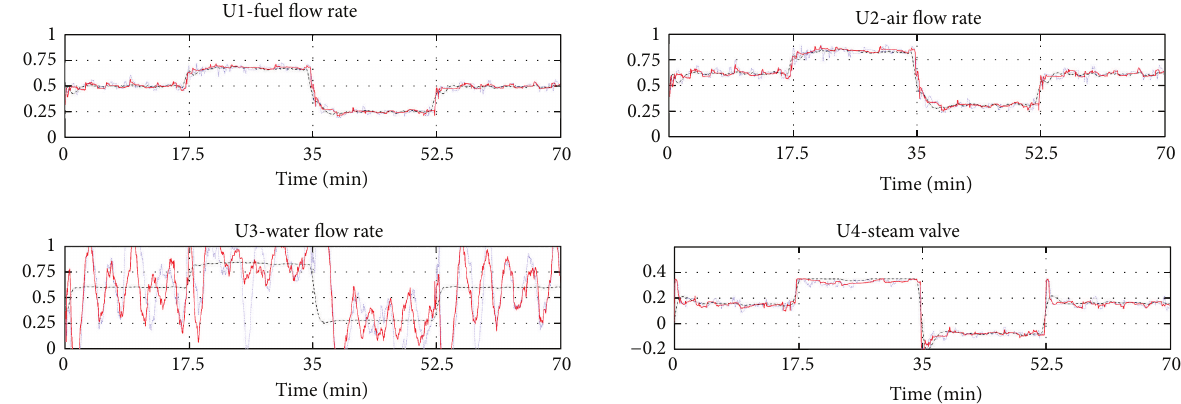
Figure 9: Control signals for the three controllers (red solid line: proposed controller; blue dotted line: conventional PSO based controller; and black dashed dotted line: linear MPC).